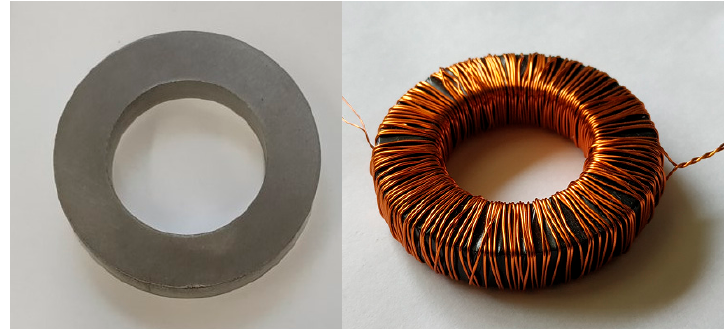
Figure 2. Exemplary cores and measuring transformer prepared by compacting Fe powder and polyvinyl chloride (PVC).